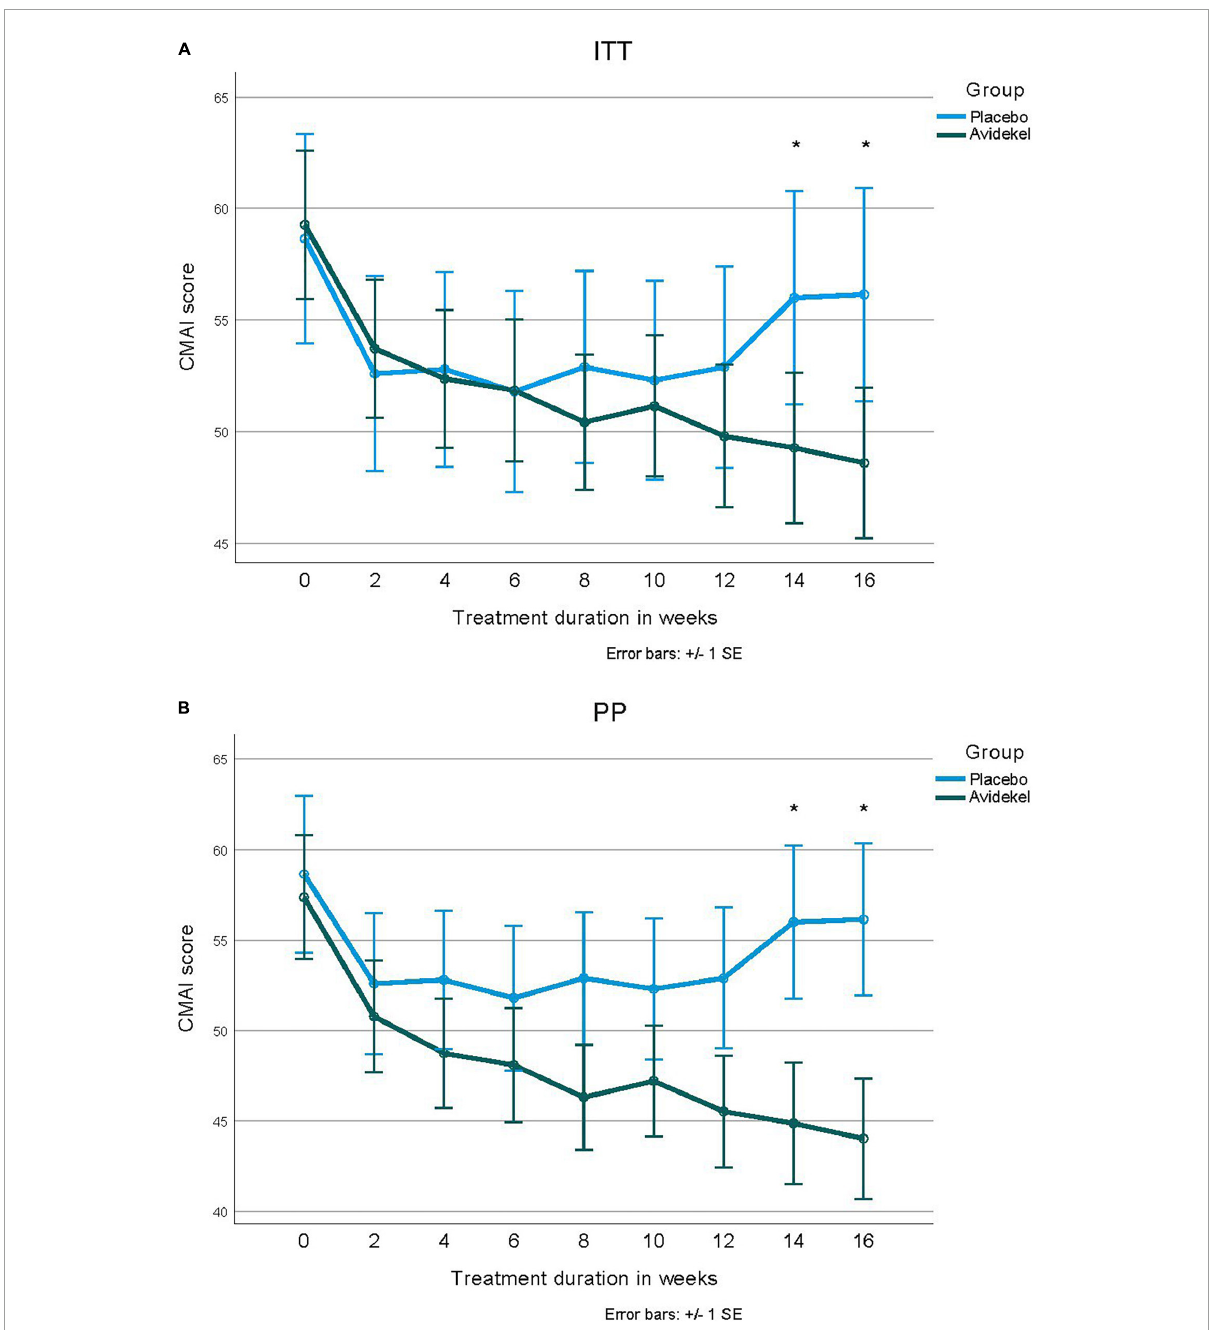
FIGURE2 The Cohen-Mansfield Agitation Inventory score reduction over time between groups. Panels (A,B) present mean CMAI scores in the two groups, throughout the trial visits both in intention-to-treat analysis of all randomized patients that initiated treatment ( n = 60), and per protocol analysis of patients who completed the trial according to protocol ( n = 52). (A) Intention-to-treat analysis. (B) Per-protocol